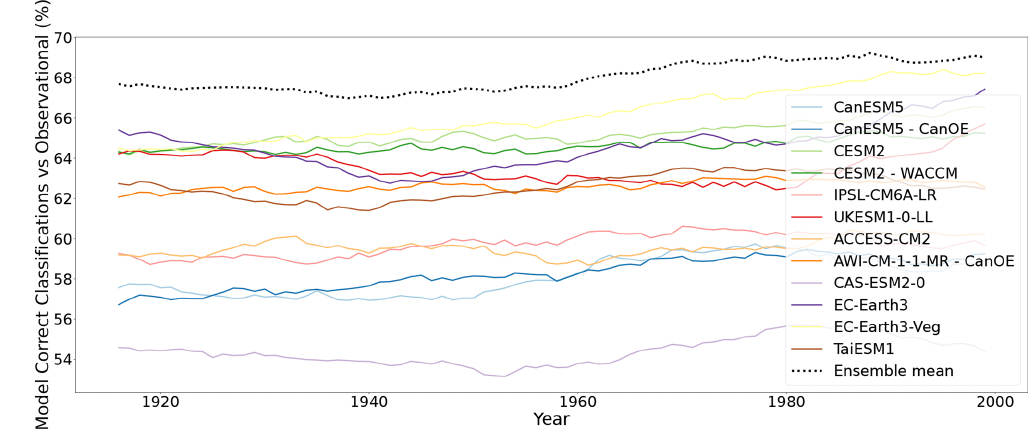
Figure 2. The percentage of land area correctly classified (without anomaly